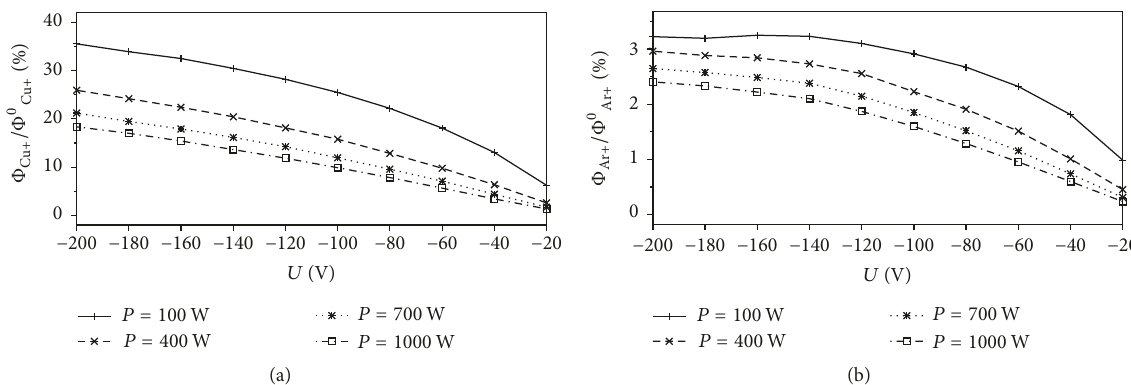
Figure 5: Ratio of flux to the bottom and flux to planar substrate of (a) Cu + and (b) Ar + ions under the whole range of studied conditions. Φ 𝑋 to the bottom of the trench; Φ 0 𝑋 to a planar substrate without trench. 𝑋 means flux of particles 𝑋 means flux of particles